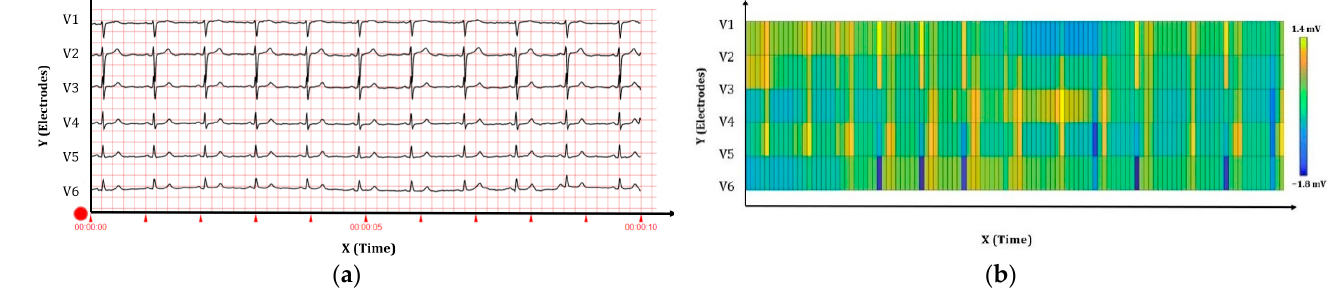
Figure 1. Examples of signals used: ( a ) ECG signal in 1D; ( b ) sECG images in 3D.